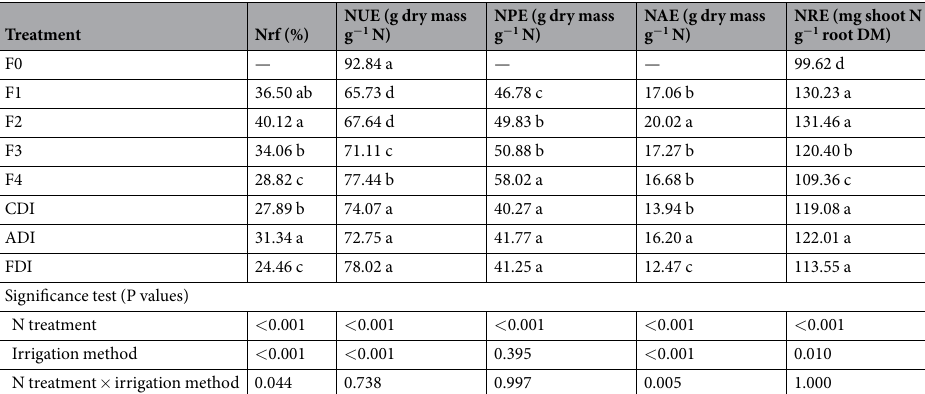
Table 5. Mean nitrogen apparent recovery fraction (Nrf), nitrogen use efficiency (NUE), nitrogen physiological efficiency (NPE), nitrogen agronomic efficiency (NAE), root nitrogen uptake efficiency (NRE) of sweet-waxy maize for different irrigation methods and N treatments. Analysis of variance (ANOVA) P values were shown ( P < 0.05, significance; P > 0.05, no significance). Different small letters in the same column are significantly different for various N treatments or irrigation methods ( P < 0.05), and the same letters are not markedly different for various N treatments or irrigation methods ( P >